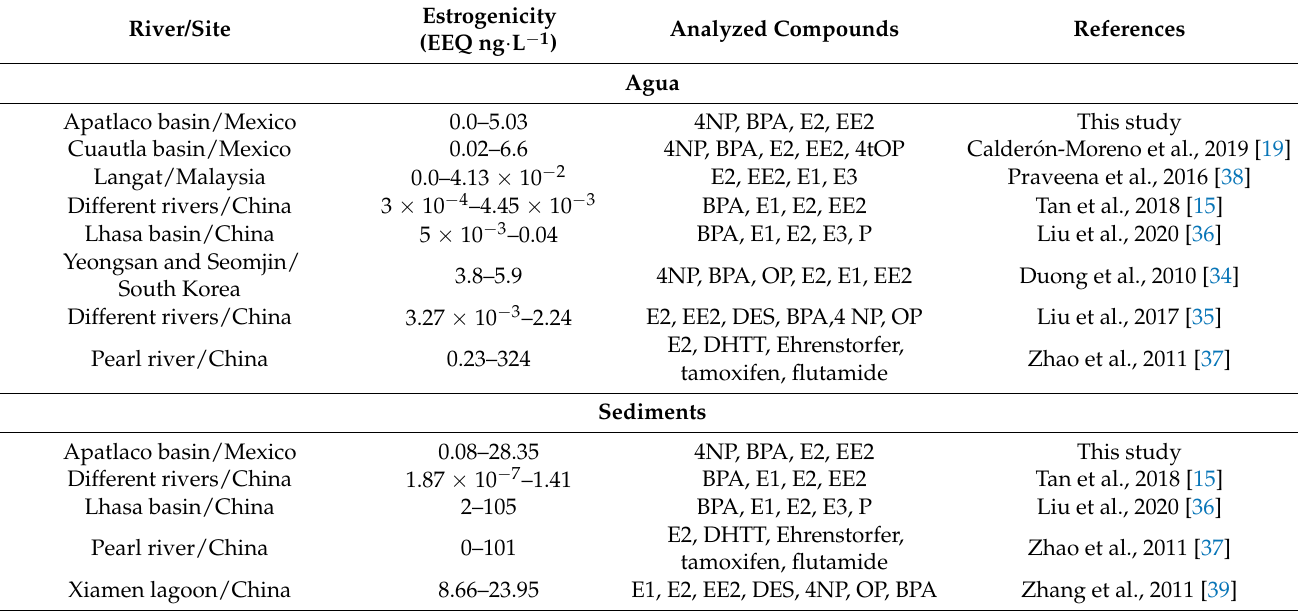
Table 8. Comparison between the estrogenicity observed in the Apatlaco River with other rivers in different parts of the